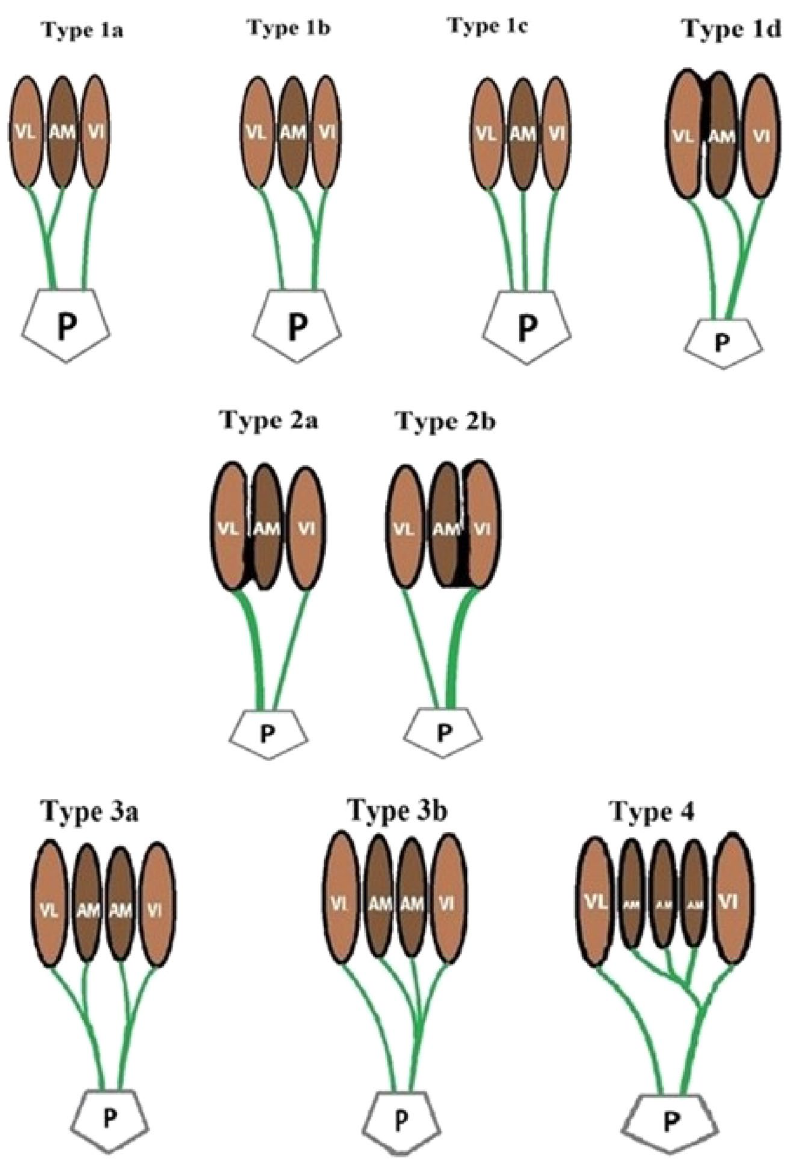
Figure 10. Morphological types of additional head of quadriceps femoris muscle; VL—vastus lateralis, VI— vastus intermedius, VM—vastus medialis, AM—additional muscle head;